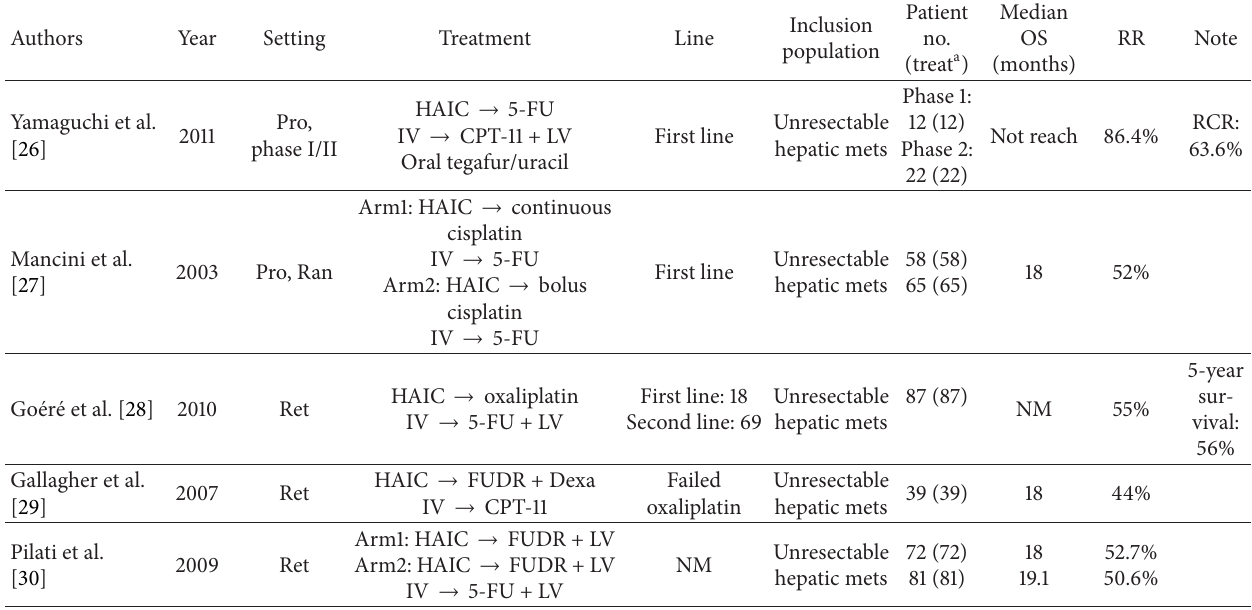
Table 1: Selective studies of combining HAIC with systemic chemotherapy for colorectal